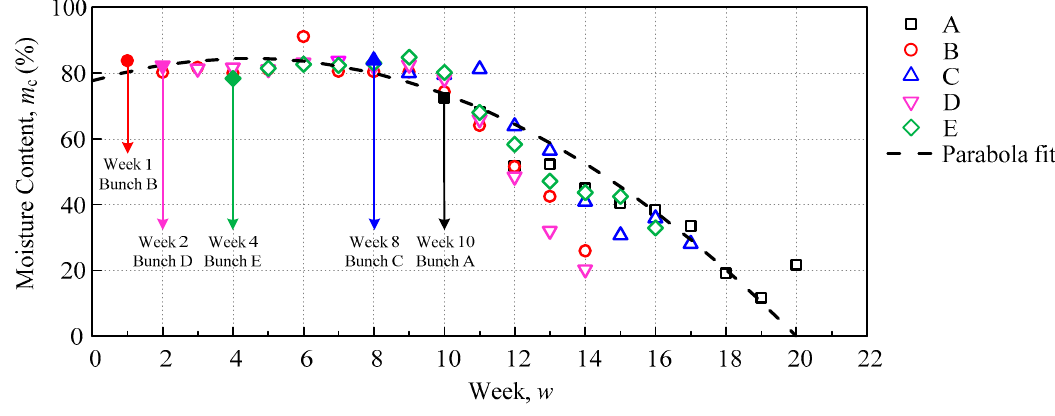
Figure 7. The moisture content for fruit sample bunch A, B, C, D, and E.